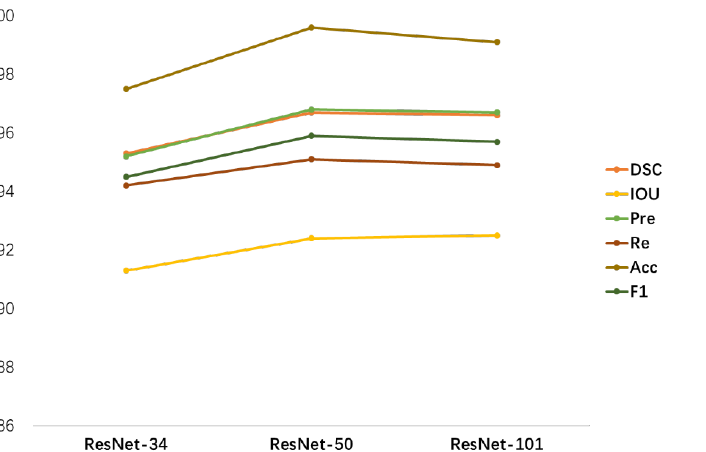
Figure 8. The influence of the three backbones on the overall segmentation performance of SEAGNET according to different metrics. according to different metrics.